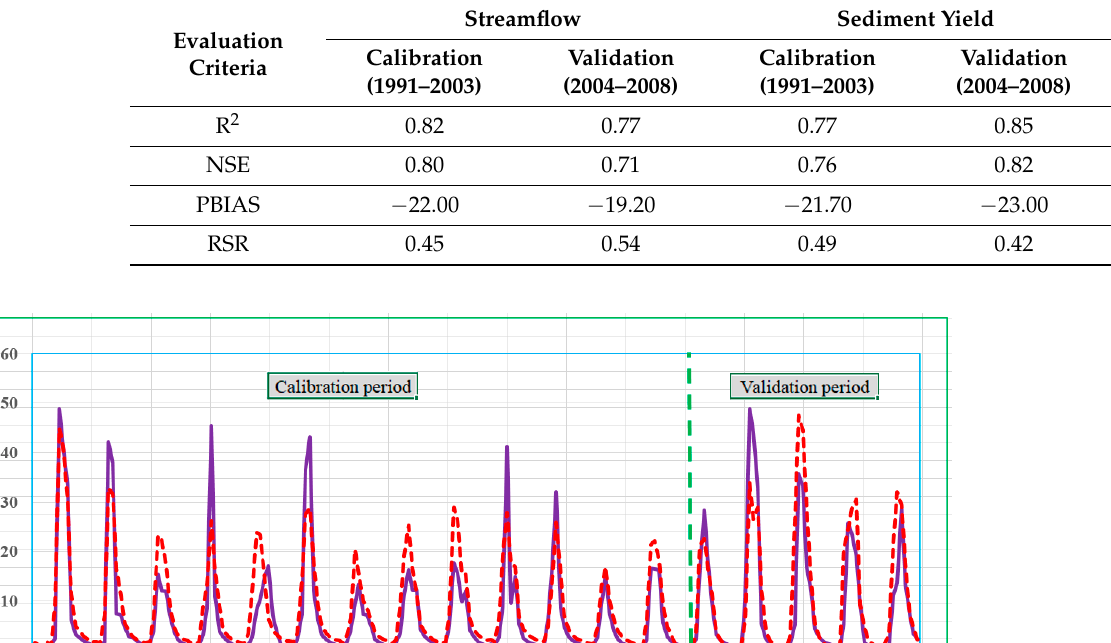
Table 5. The streamflow and sediment yield calibration and validation results.